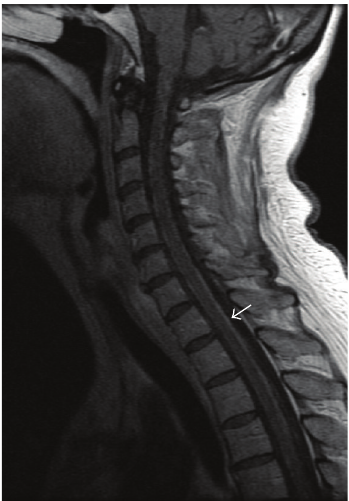
Figure 2: Sagittal T 1 postcontrast image of the cervical spine: linear leptomeningeal enhancement along the cervical and visualized upper thoracic spinal cord.